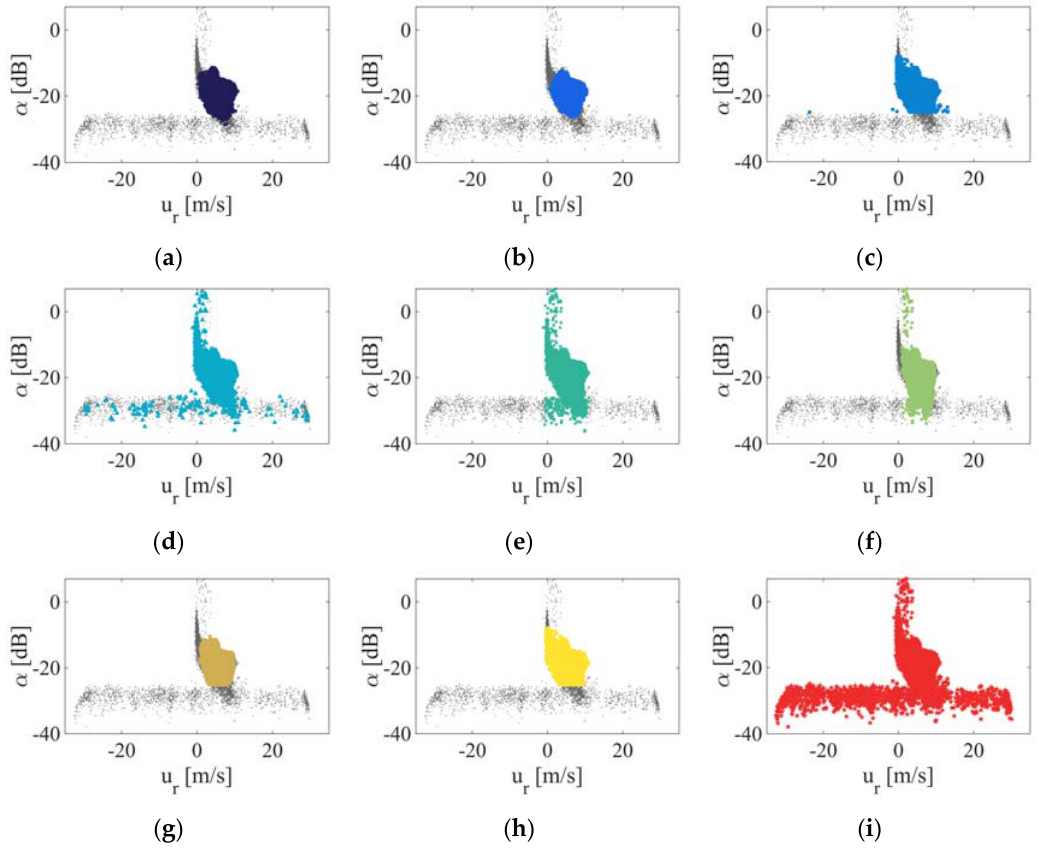
Figure 17. Results of application of different filtering methods in the u r - α diagram. ( a ) histogram-based dynamic data filter, ( b ) Gaussian kernel based dynamic data filter, ( c ) CNR-threshold filter, ( d ) two sigma standard deviation filter, ( e ) iterative standard deviation filter, ( f ) interquartile-range, ( g ) combined filter approach by Wang et al., ( h ) combined filter approach by Newman et al., ( i ) no filtering.